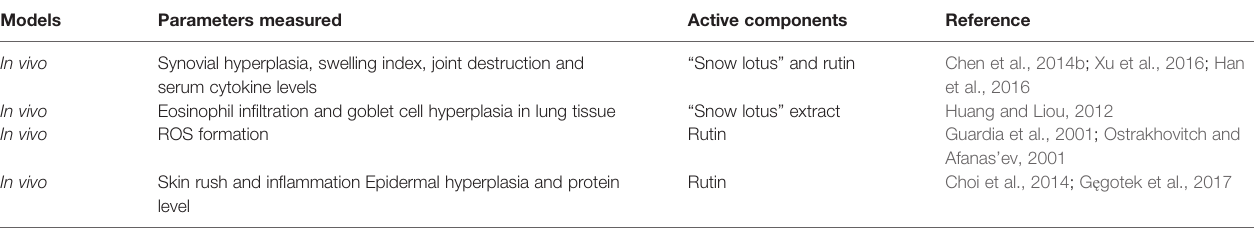
TABLE 5 | Summary of anti-in fl ammatory functions of “ Snow lotus ” and/or its major